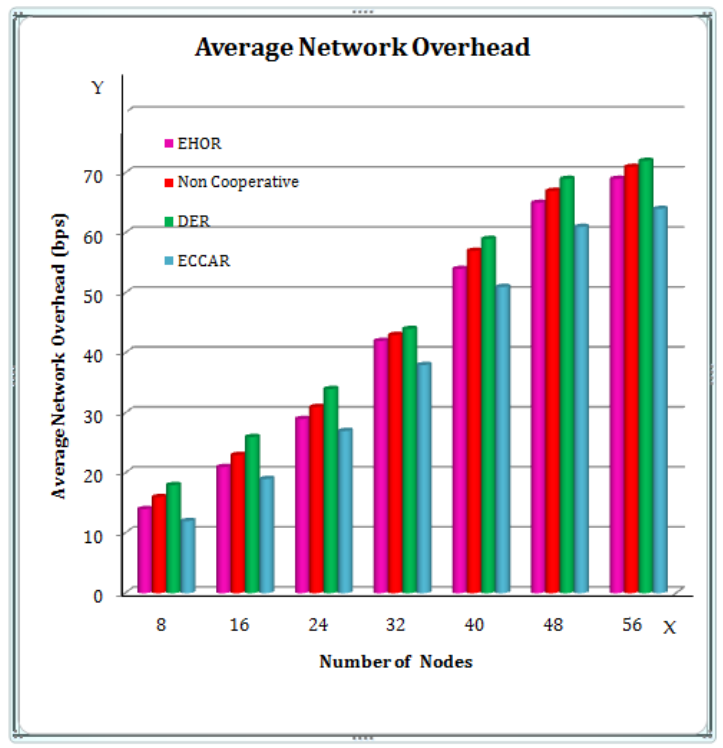
Figure 6. Average Network overhead.